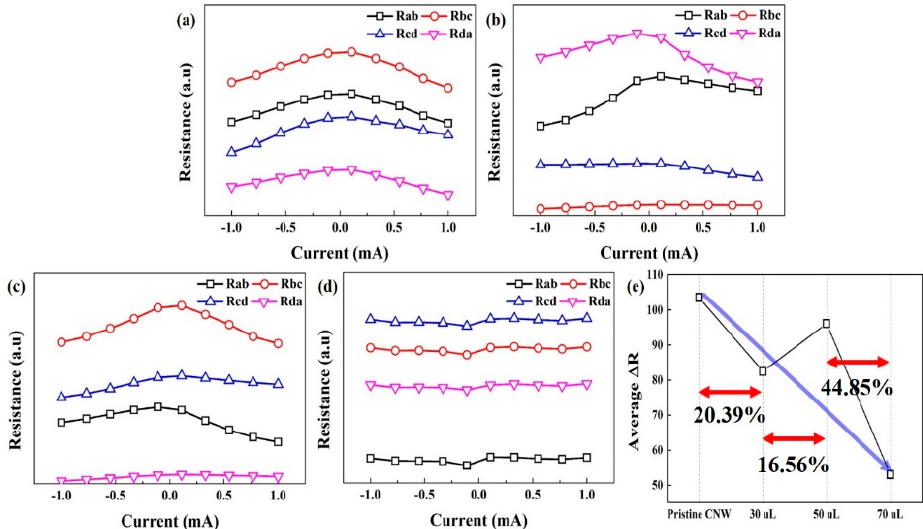
Figure 6. Electrical stability with I-R curve of all samples: ( a ) pristine CNW; ( b ) MWCNT (30 µL)/CNW; ( c ) MWCNT (50 µL)/CNW; ( d ) MWCNT (70 µL)/CNW; ( e ) average Δ R with percentage.